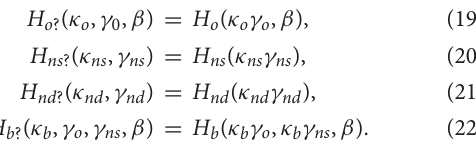
TABLE 3 | Affirmation and challenge of cues by probes; corresponding features,